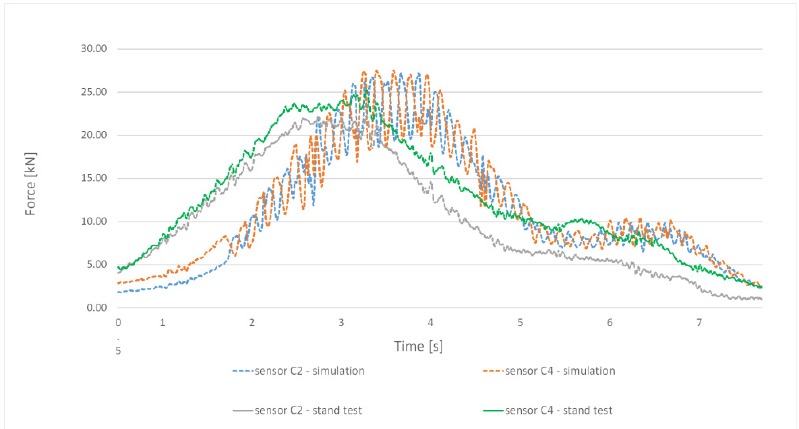
Figure 7. Force values in the vertical suspensions at travel speed 3 m/s. Forces in the diagonal suspensions at travel speed 3 m/s are presented in Figure 8.